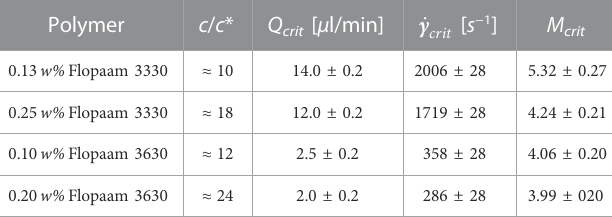
M crit at the onset of purely